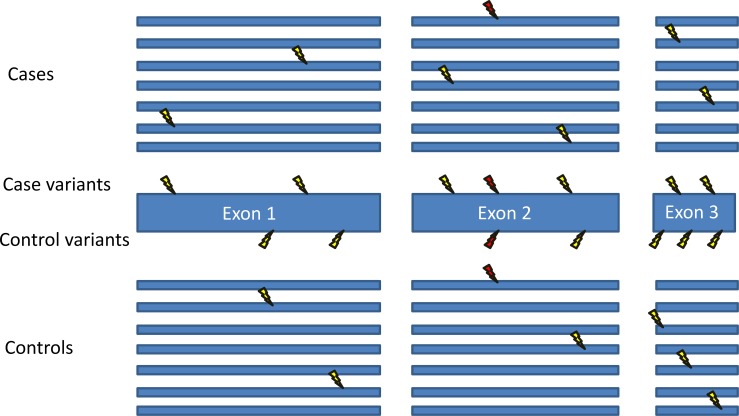
Gene-based collapsing analysis.Shown is the basic schematic for a gene-based collapsing analysis. A gene is completely sequenced in cases and controls, and the number of cases and controls with rare mutations (lightning bolts) in the gene is compared. In contrast, many published articles only use controls to look for the specific variants found in the cases. For example, here the red lightning bolt indicates a variant that is found in both a case and a control. If only case variants are considered, then there are seven cases with different mutations in this gene, and only one of these mutations is found in controls. However, if all variants in the gene are considered, then there are an equal number of cases and controls with mutations in this gene. This collapsing technique can also be used to assess and implicate a gene region instead of an entire gene, for example in S1 Fig and in [16,17].